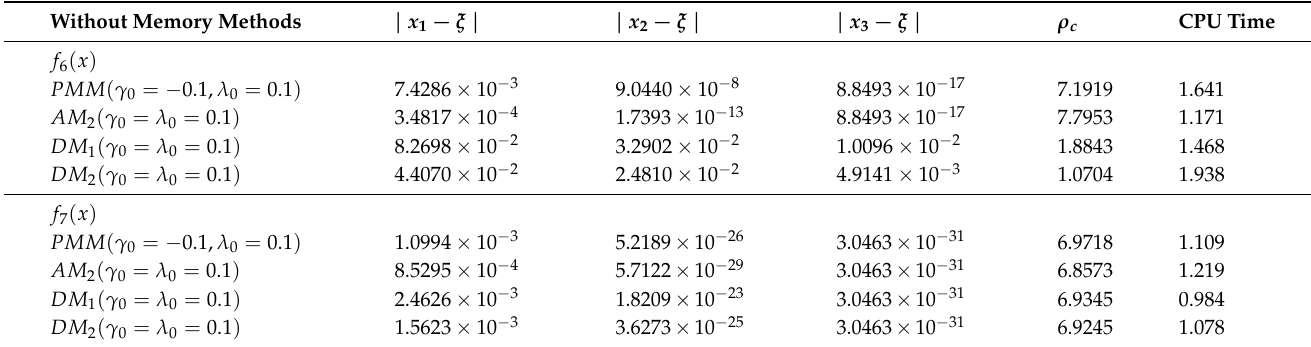
Table 5. Comparison of the different methods with memory for real-life